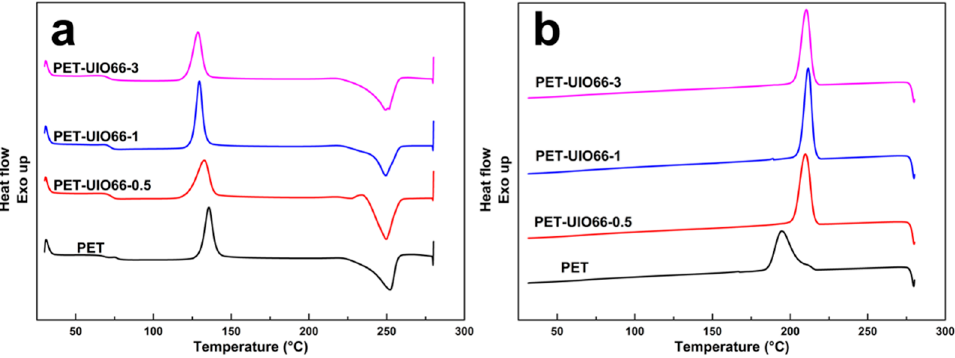
Figure 3. DSC thermograms of the PET/UIO-66 nanocomposites: ( a ) first heating scans and ( b ) cool- ing scans. Table 1. Thermal behaviors of PET and PET/UIO-66 nanocomposites obtained from DSC. 1st Samples